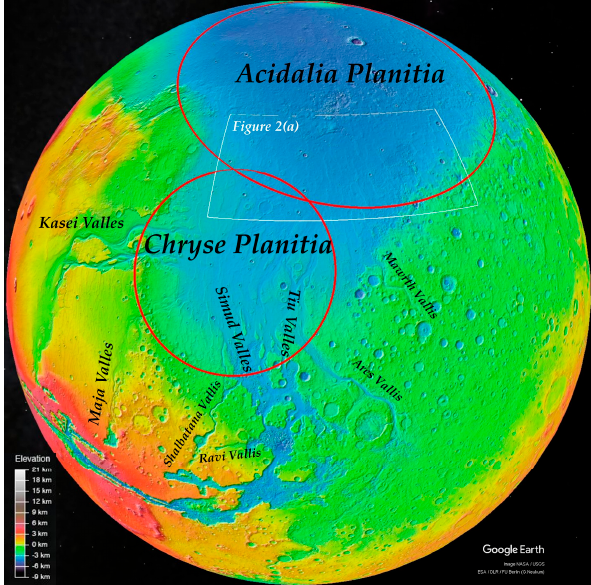
Figure 1. Mars globe overlain by Mars Orbiter Laser Altimeter (MOLA) shaded relief/colorized elevation map (Image credit: Google Earth). Red circles show the approximate outlines of quasi circular depressions (buried impact basins, Chryse and Acidalia Planitia) [18]. Note that all of the named valleys represent circum-Chryse outflow channels.